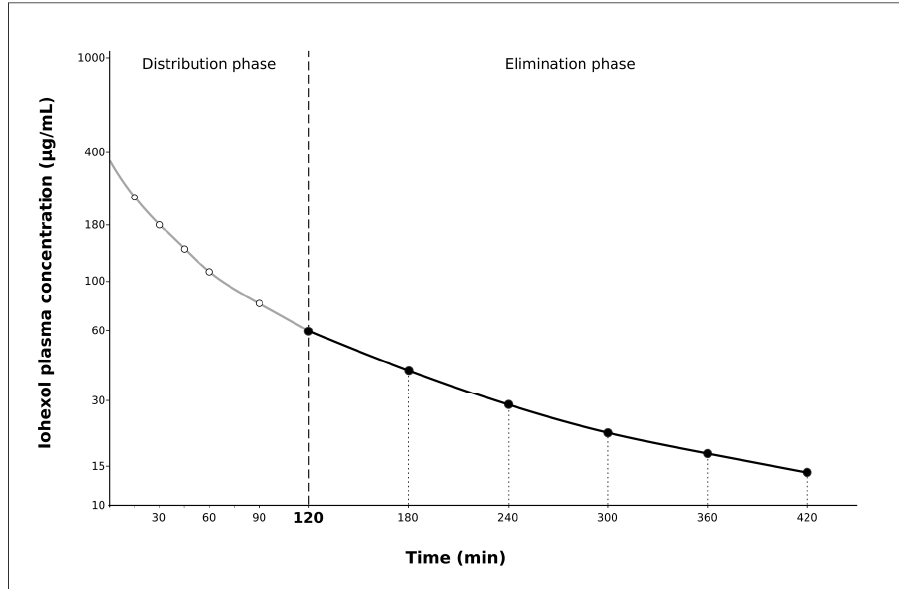
Figure 2. Pharmacokinetic profile of the iohexol plasma clearance considering a two-compartment model (CL2) in representative swine. Sampling time points are indicated by white circles (at 15, 30, 45, 60, and 90 min) for the distribution phase and by black circles (at 120, 180, 240, 300, 360, and 420 min) for the elimination phase. The one-compartment model (CL1) considers only the elimination phase.